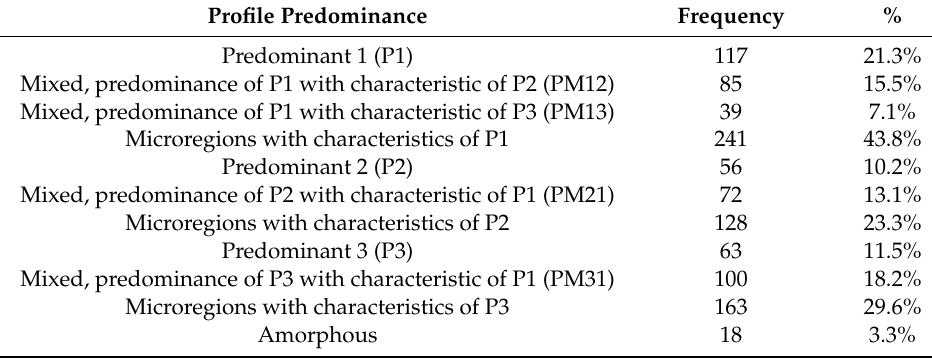
Table 2. Typology of the microregions, according to the predominance of the